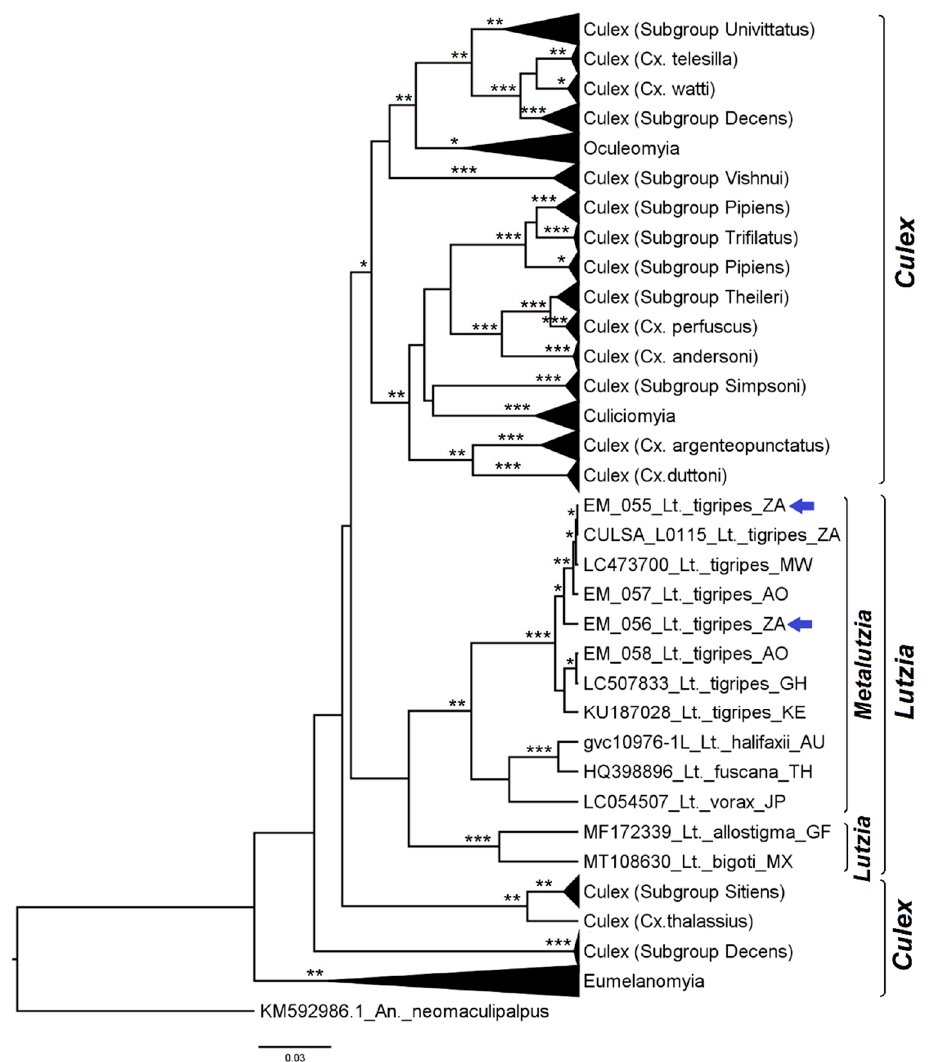
Figure 13. Phylogenetic analysis of 170 partial coxI nucleotide sequences from mosquitoes of the Culex and Lutzia genera, presenting the Lutzia genus. At specific branches, the number of * indicates the tree topological support revealed by the different phylogenetic reconstruction methods, assuming relevant bootstrap and aLRT values above 75% and posterior probability values above 0.80. The sequences obtained in this work are indicated by the “EM” code and those with associated genitalia are indicated by horizontal blue arrows. The sequences downloaded from GenBank and Boldsystems are indicated by their respective accession numbers and access codes (respectively). Their country of origin [South Africa (ZA), Angola (AO), Australia (AU), Ghana (GH), French Guiana (GF), Japan (JP), Malawi (MW), Mexico (MX), Kenya (KE), Thailand (TH)] are also indicated. The vertical lines mark the Culex genus and the Lutzia genus and its subgenera.